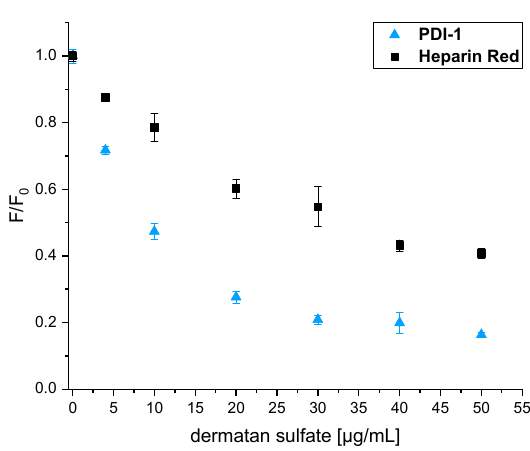
Figure 3. Normalized dose response (F/F 0 ) curves of PDI-1 and Heparin Red to dermatan sulfate in human plasma. Spiked pooled normal plasma samples. Manually performed microplate assay was conducted, following the protocol of the supplier for the Heparin Red Kit (using 100-µM solutions of either Heparin Red or PDI-1 ). Excitation at 570 nm, fluorescence emission at 605 nm. Averages of duplicate determinations; error bars show standard deviation.